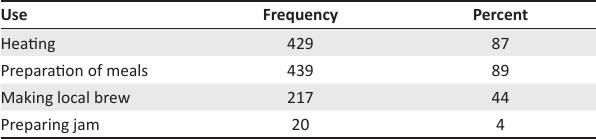
TABLE 3: Uses of wood energy by rural